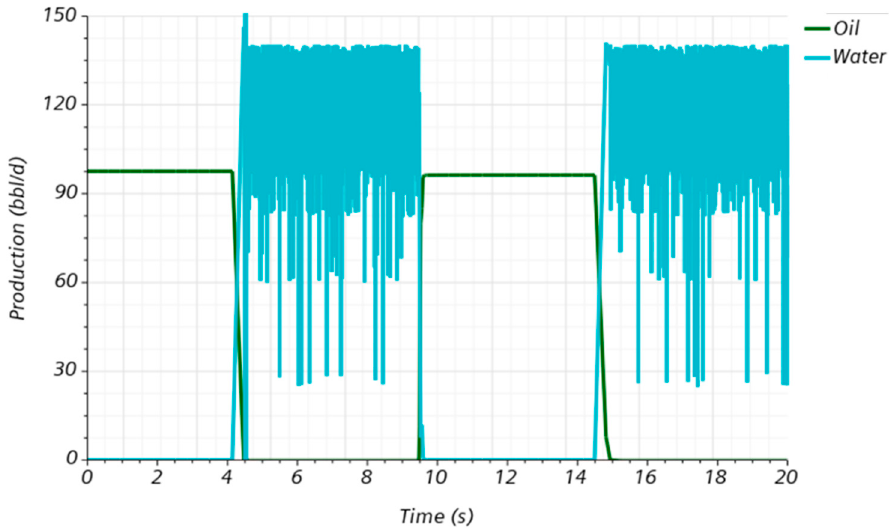
Figure 6. Production profile for the RCP analysis.